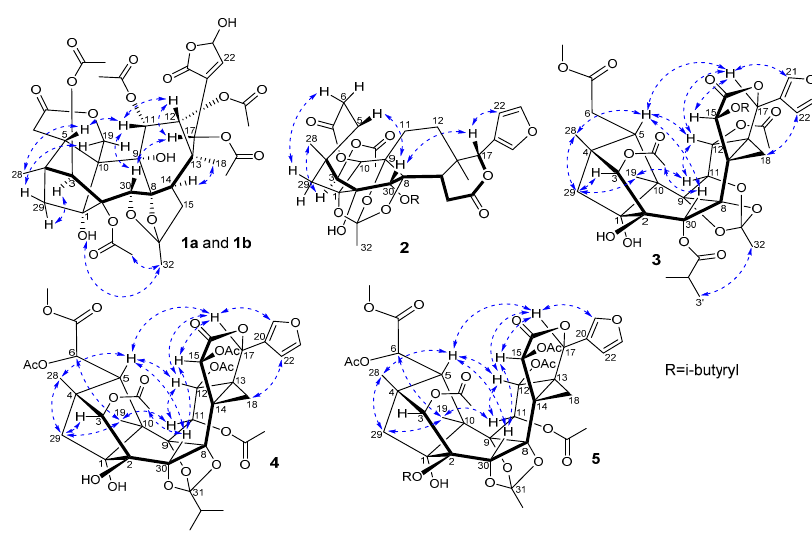
Figure 3. Key ROESY correlations for compounds 1 – 5 .